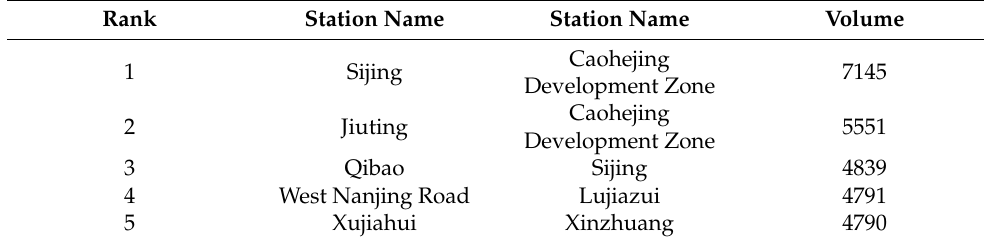
Table A3. Top 5 station interaction